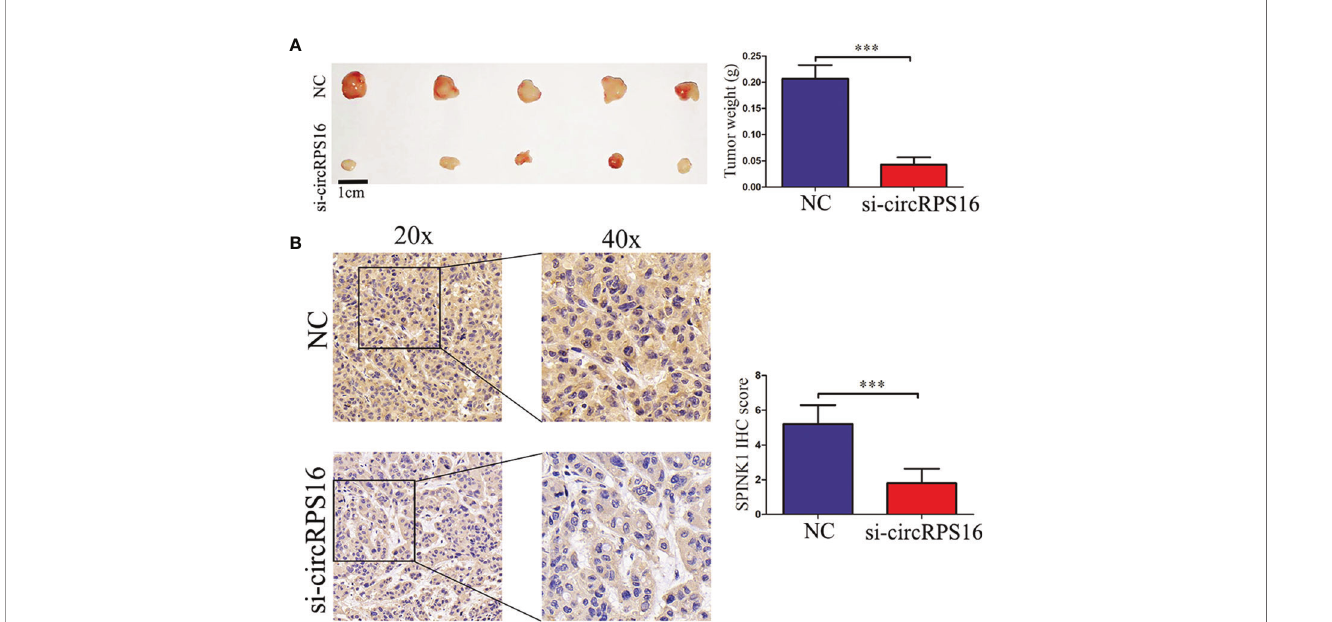
FIGURE 6 | circRPS16 knockdown inhibits tumor growth in vivo . (A) After four weeks, the implanted mice were killed and the tumor weights were recorded. Data are presented as mean ± SD; statistical signi fi cance was assessed by Student ’ s t -test. *** p < 0.001. (B) The SPINK1 expression levels in each group were measured through IHC analysis. Data are presented as mean ± SD; statistical signi fi cance was assessed by Student ’ s t -test. *** p < 0.001. NC, negative control; si,